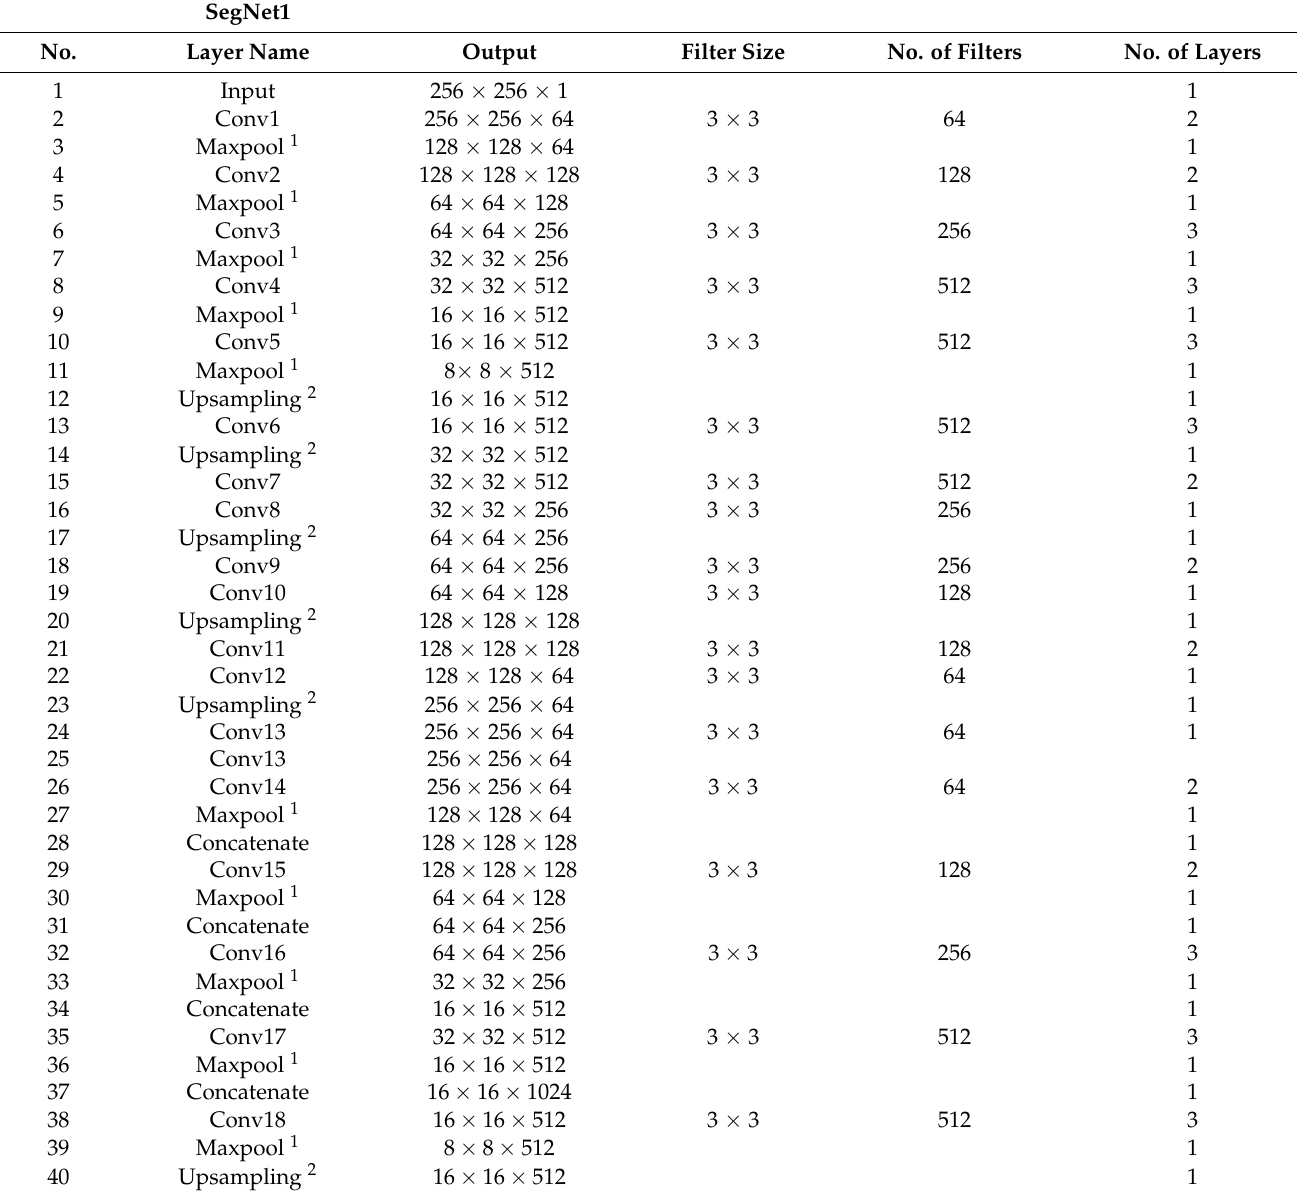
Table 3. The detailed architecture of the proposed